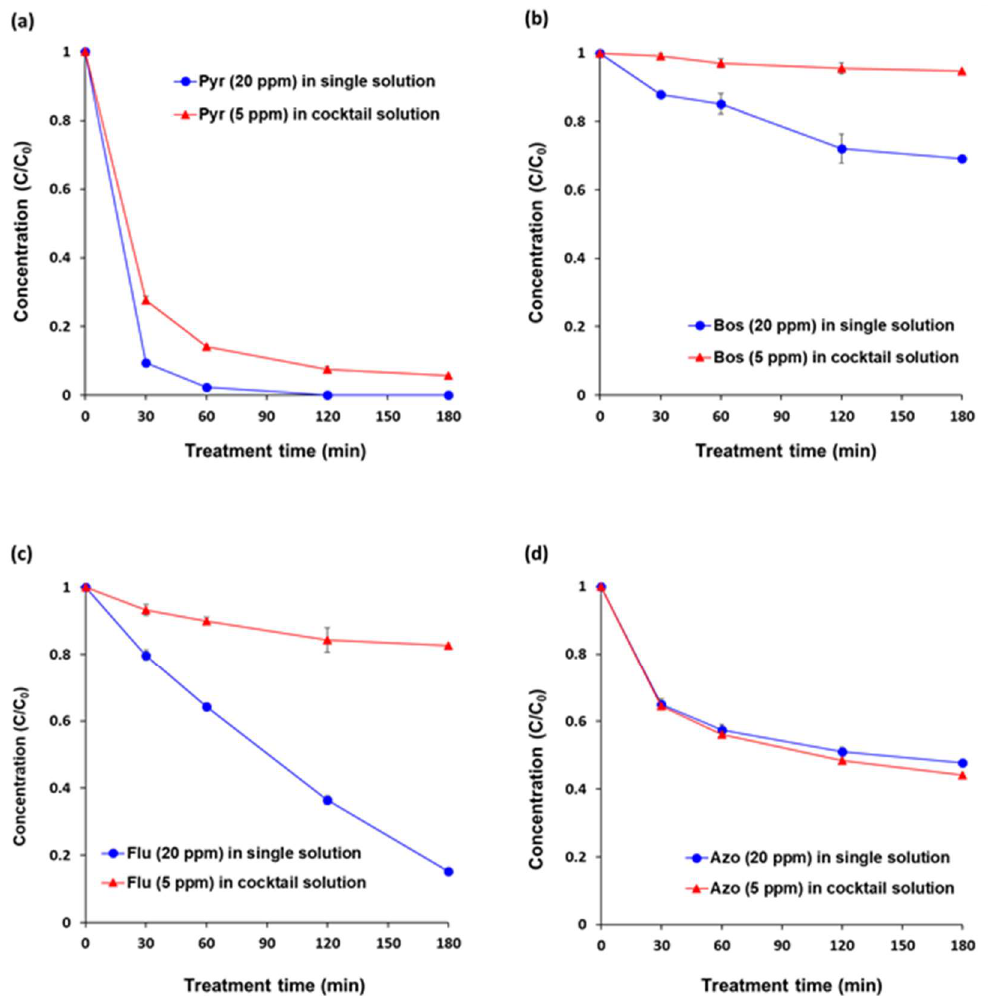
Figure 3. Degradation efficiencies of the VUV-assisted TiO 2 photocatalytic treatment (VUV-TiO 2 ) in a cocktail solution of pesticides. ( a ) pyraclostrobin (Pyr), ( b ) boscalid (Bos), ( c ) fludioxonil (Flu), and ( d ) azoxystrobin (Azo). The pesticide concentration of each single solution was 20 ppm (w/v). The concentration of each pesticide in a cocktail solution was 5 ppm (w/v) and the total pesticide concentration of the cocktail solution was 20 ppm (w/v). All of the treatments were performed under magnetic stirring at 300 rpm. Results represent the mean of three measurements ± standard deviation.